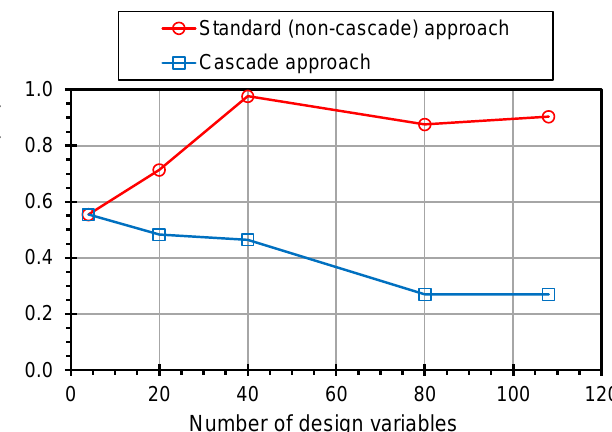
Figure 7. Test Problem 1 (wing box): trade-off relation between the number of design variables and the finally attained objective function